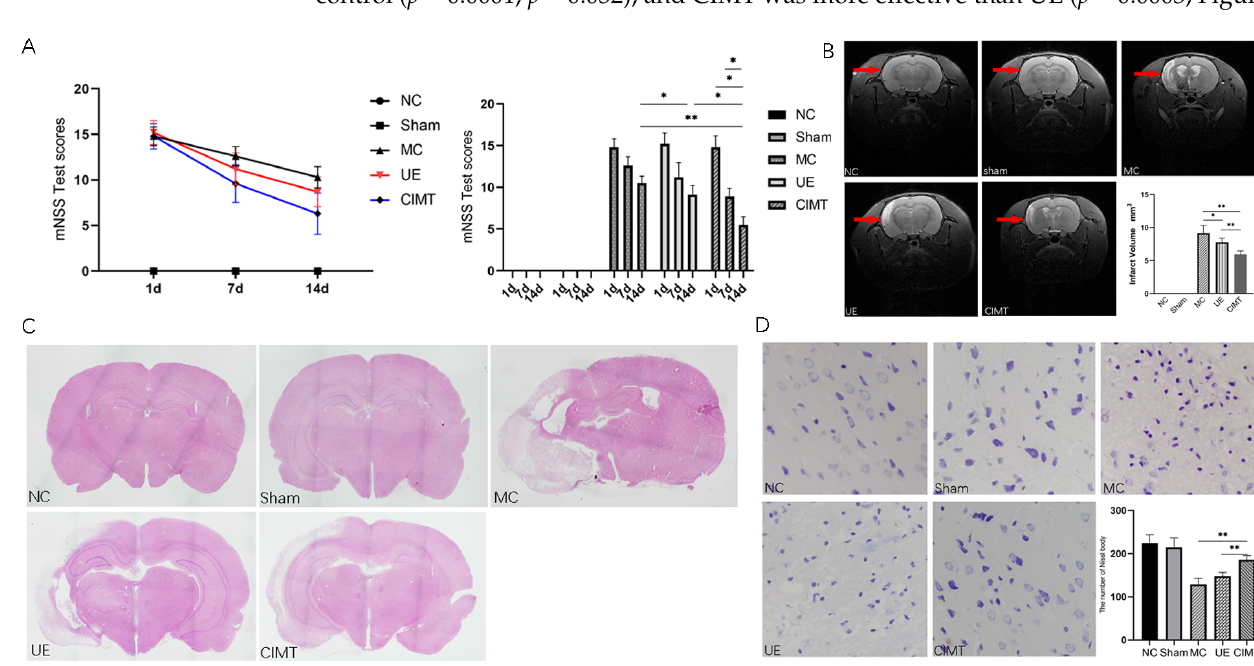
Figure 3. CIMT was more effective than UE in improving limb function in MCAO/R rats. ( A ) the mNSS test of rats in each group on days 1, 7, and 14; ( B ) coronal images of brain MRI performed after the intervention. The infarction regions were indicated by red arrows in the MRI, and the infarction volume of each group was calculated; ( C ) hematoxylin–eosin staining of coronal sections of brains in each group; ( D ) Nissl staining of the brain tissues in each group. The number of Nissl bodies was calculated. NC: normal control; MC: model control; CIMT: constraint-induced movement therapy; UE: unconstraint exercise. *: p < 0.05; **: p < 0.01.